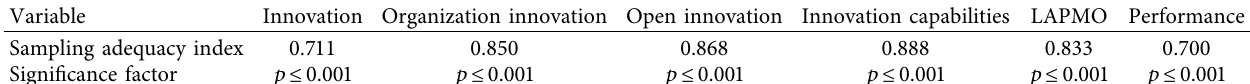
Figure 2: Te conceptual model of the study (made by researchers). Table 4: Reliability statistics of the research variables (made by researchers).